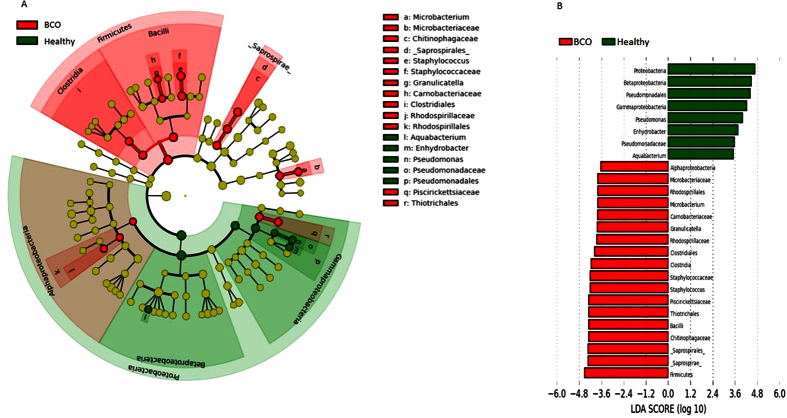
Differentially abundant taxa identified using LEfSe analysis using blood microbiota of chickens with relative abundance ≥0.1.(a) Taxonomic cladogram produced from LEfSe analysis. Red and green shows taxa enriched in BCO and healthy chickens, respectively. Brightness is proportional to the abundance of taxon. (b) Taxa enriched in BCO chickens are shown in red with negative LDA score and healthy chickens in green with positive LDA score (>3.5 in both cases). Taxon between two underscore is proposed name of GreenGene database.